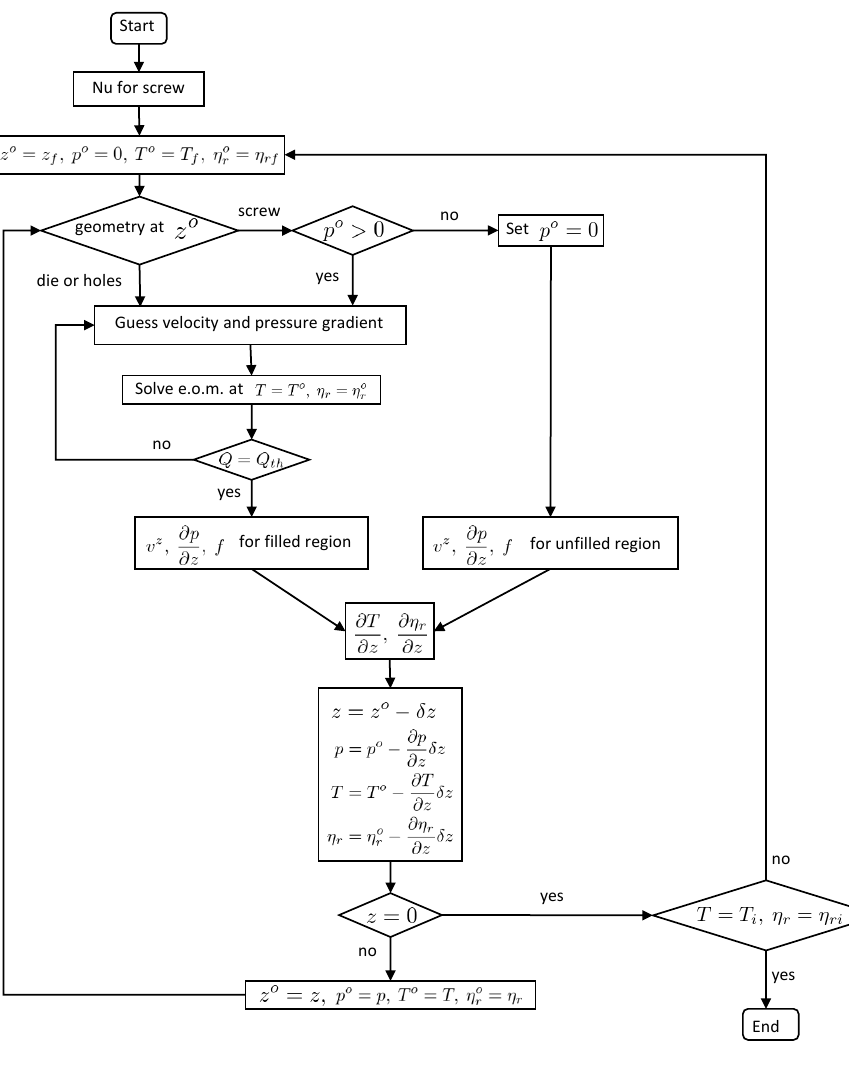
Figure 2. Flowchart of numerical calculation. The Q th is defined by the right hand side of Equation (3) or Equation